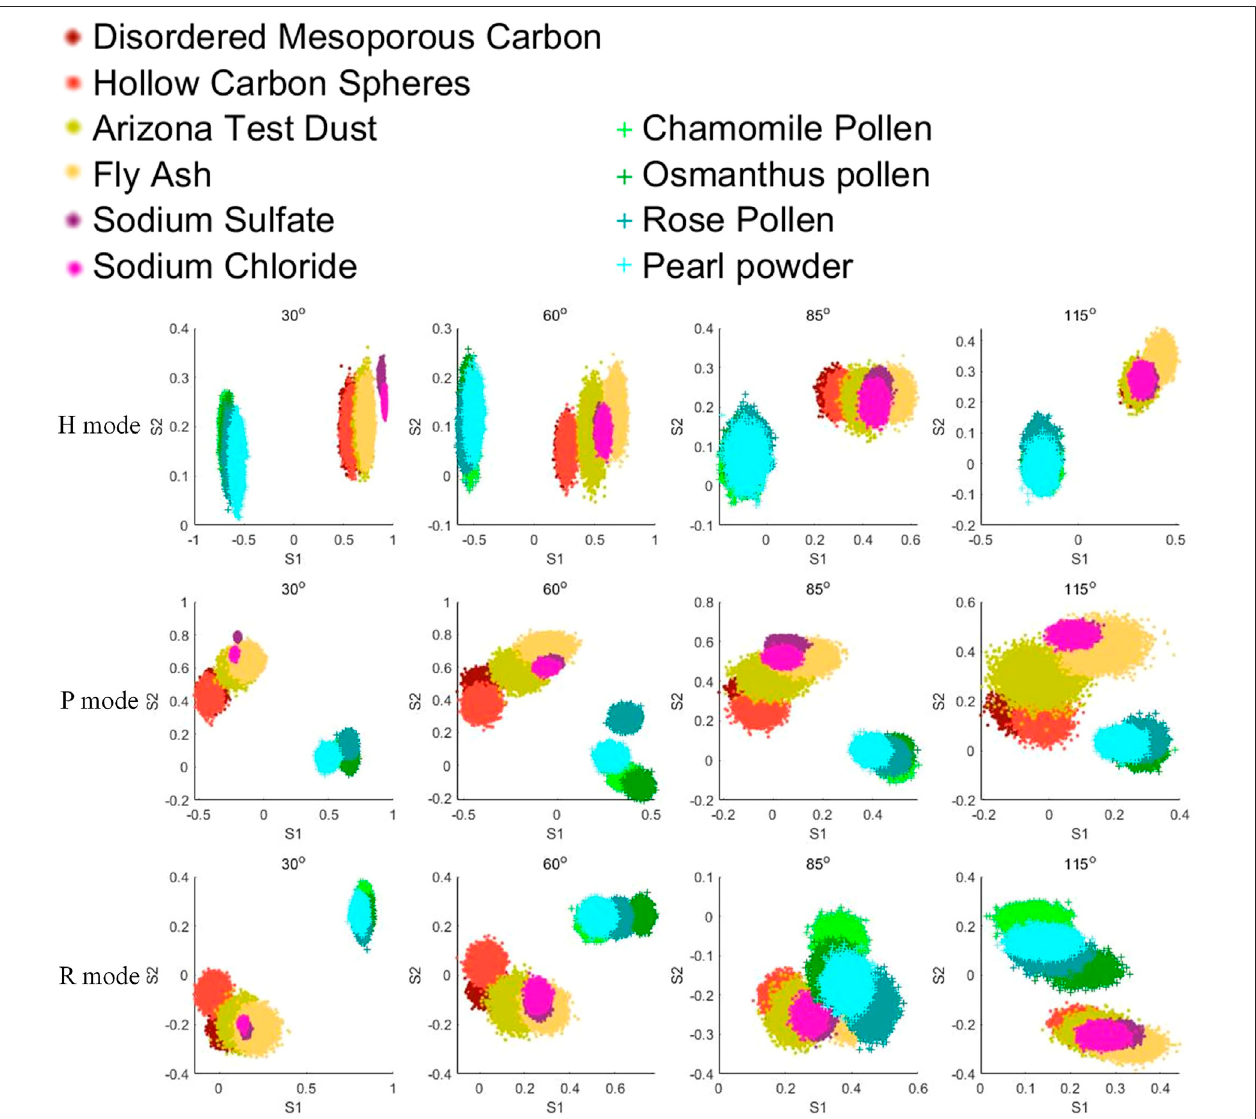
FIGURE 2 | Pollen and non-biological samples under the multi-angle polarization index system (MAPIS), 10,000 samples for each type.